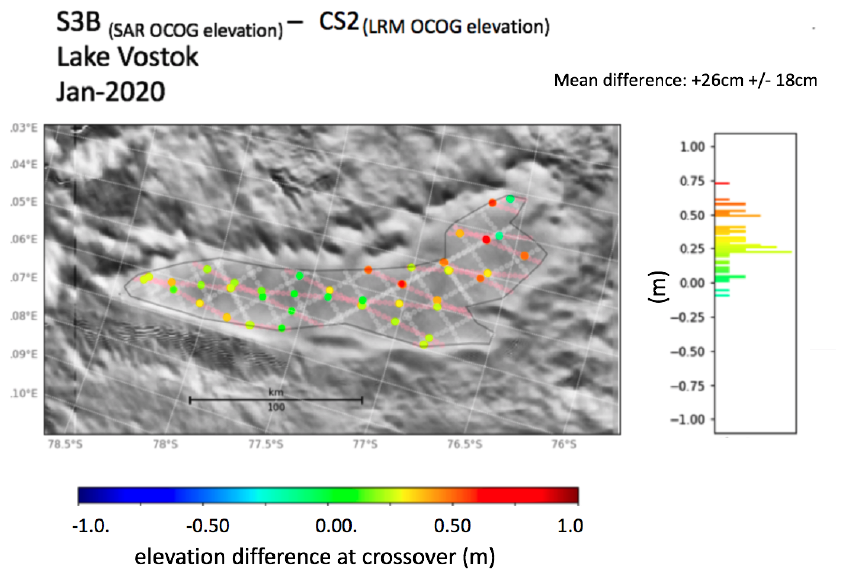
Figure 38. Comparison of S3B with CryoSat-2 (LRM mode) over Lake Vostok. The plotted variable is the difference in heights recorded by S3B and CryoSat-2 at their mutual crossover points.